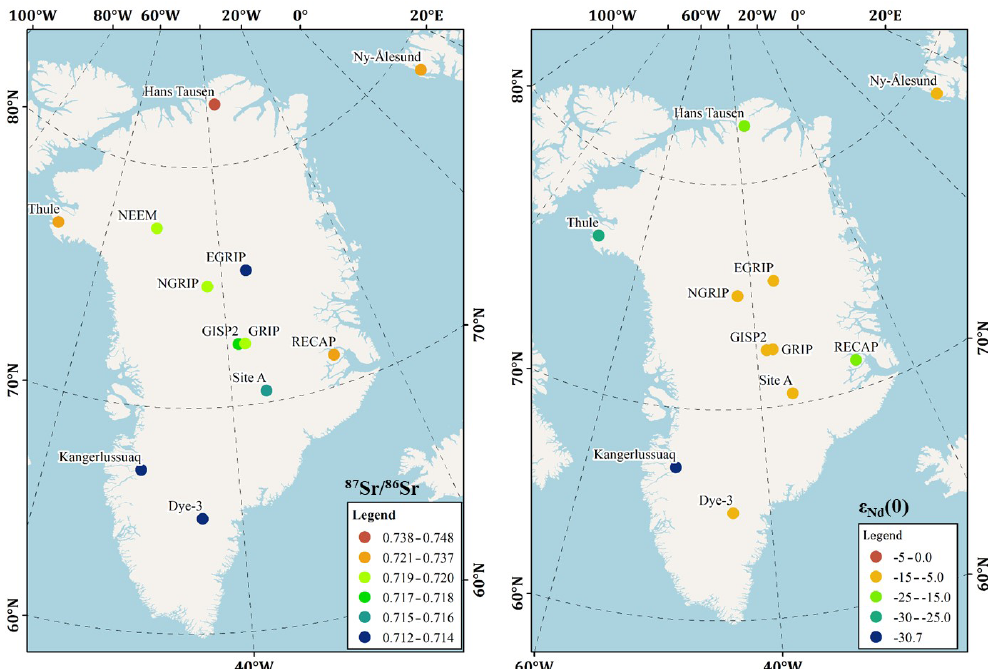
Figure 5. 87 Sr / 86 Sr and ε Nd (0) data in snow or ice cores and sand/soil samples from Ny-Ålesund, Svalbard, and GrIS. (This figure was created with